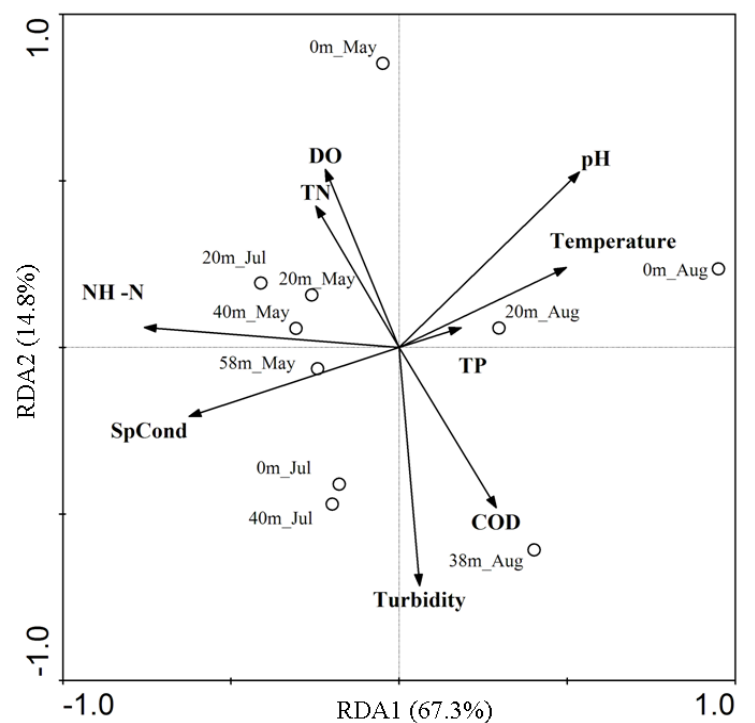
Figure 8. Redundancy analysis (RDA) between the bacterial community composition (BCC) and environmental parameters in the Jinpen Drinking Water Reservoir, China. Samples are represented by open circles. Numbers in brackets represent the percentage of variation of the data explained by each factor, RDA1 explains 67.3% of the total variation and RDA2 explains 14.8% of the total variation, respectively. The primary factors for the variables of the environmental data are represented by arrows (DO = dissolved oxygen; SpCond = specific conductivity; TN = total nitrogen; TP = total phosphorus; NH 4 -N = ammonia nitrogen; COD Mn = permanganate